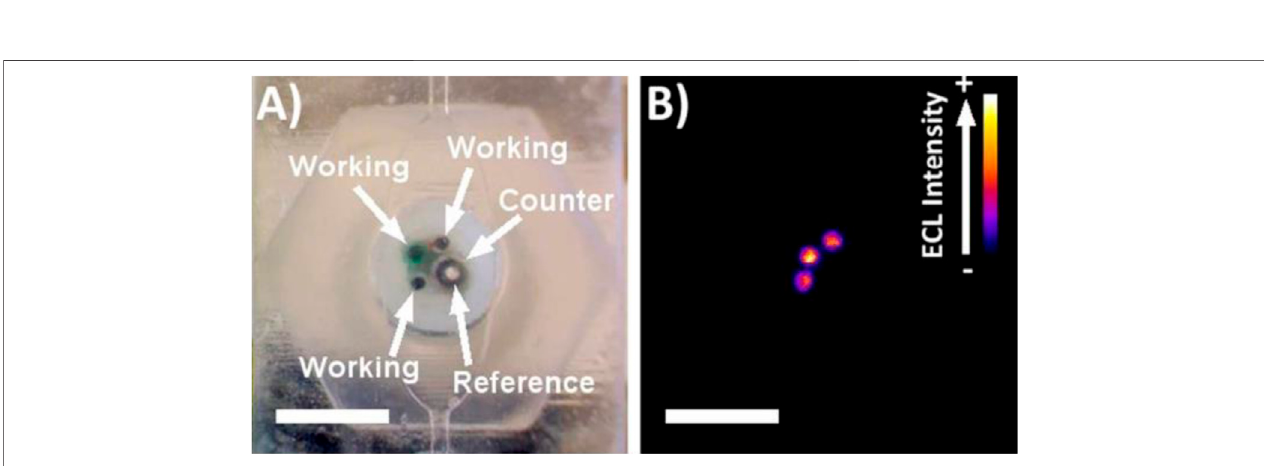
FIGURE7|(A) Pictureofelectrodearraysincorporatedinto3D-printedchannel. (B) ECLresponsefromelectrodearrayin180 µM[Ru(bpy) 3 ] 2+ in0.2 Mphosphate buffer with 100 mM TPA (reproduced with permission from Bishop et al., 2015).